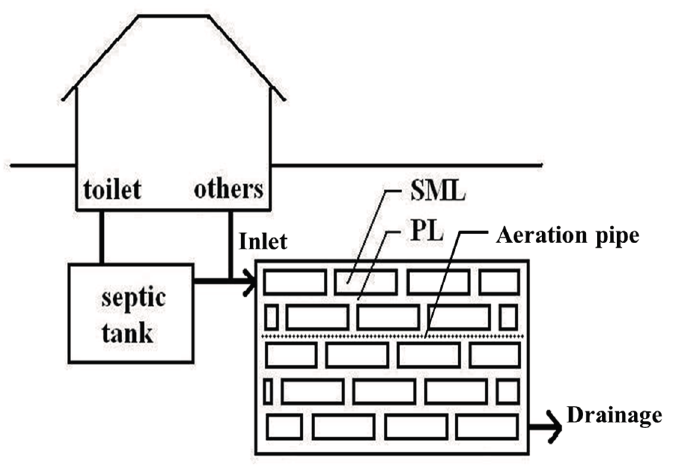
Figure 1. An MSL system for wastewater treatment of a single residential